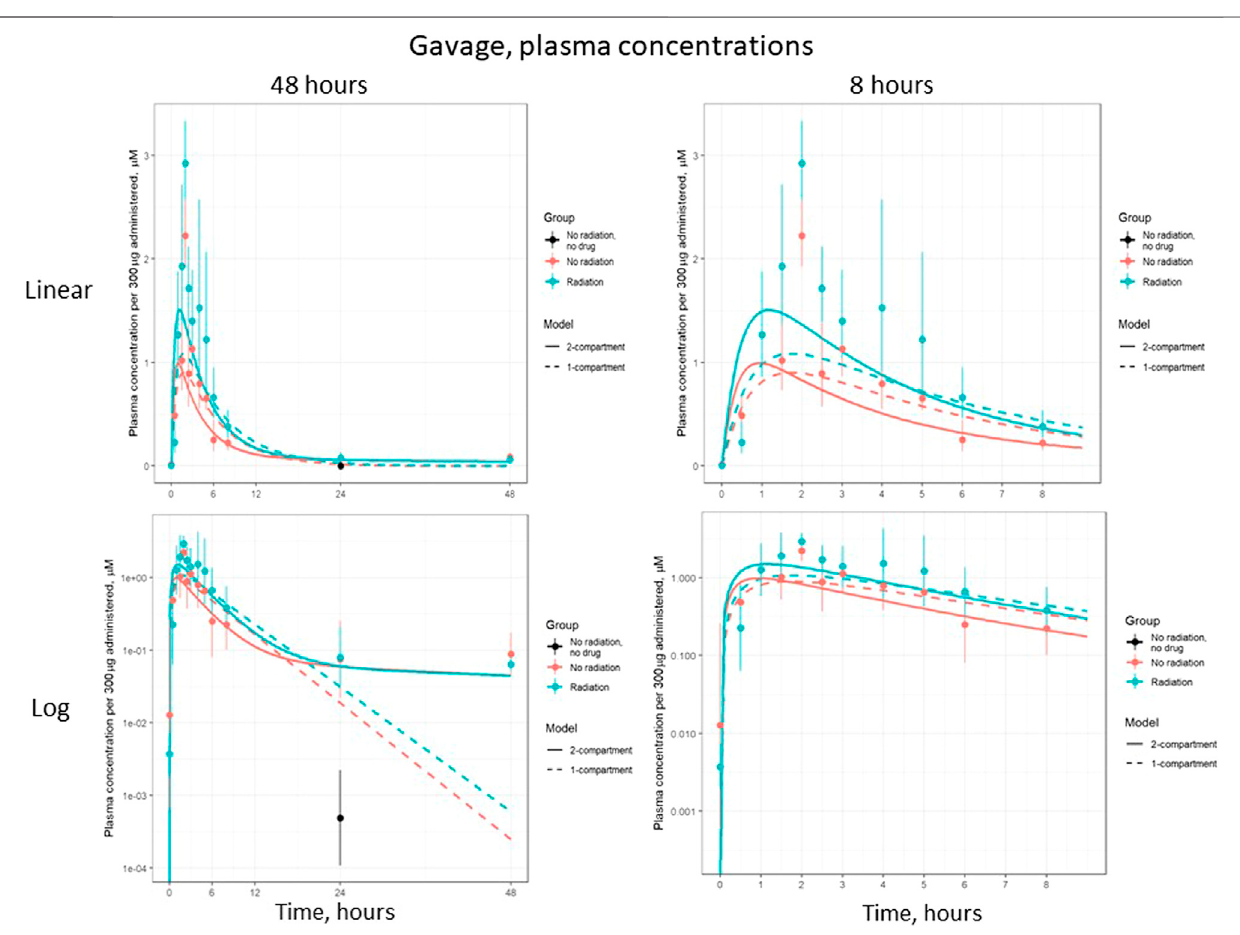
Frontiers in Pharmacology |